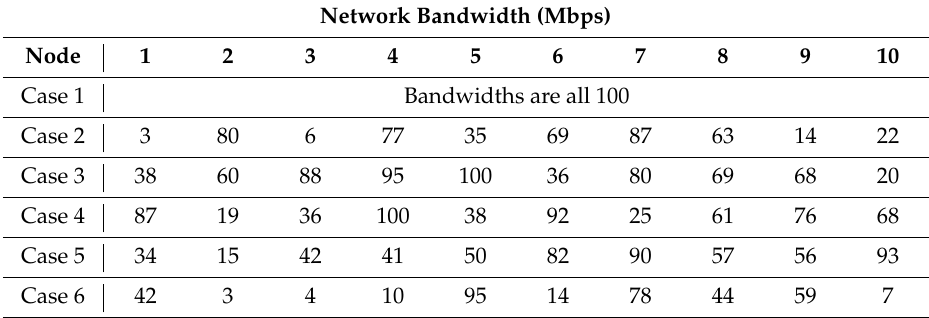
Table 1. Simulation of di ff erent network bandwidths used in the